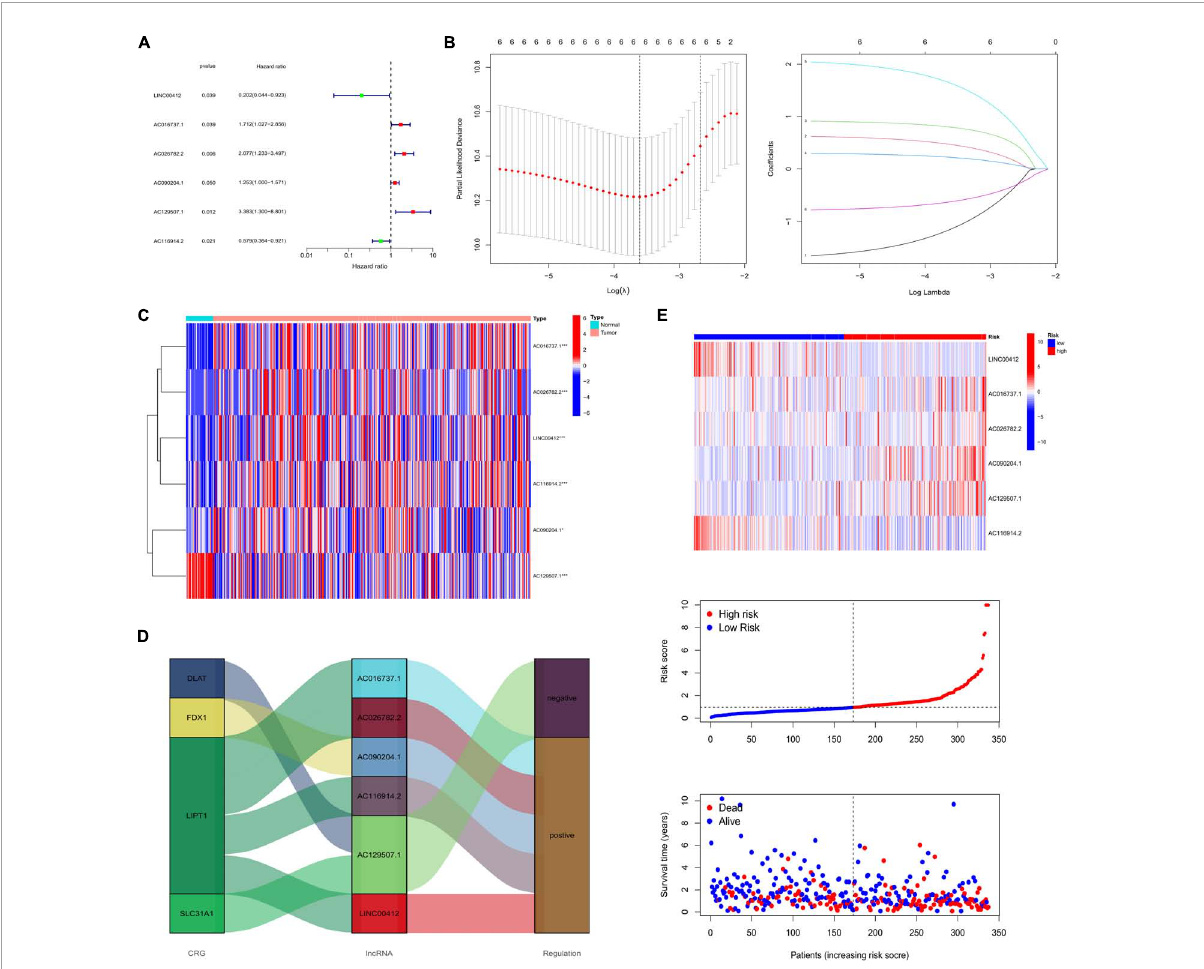
FIGURE2 (A) Univariate Cox regression analysis. (B) The LASSO algorithm further selected the most crucial genes and LASSO coefficient profiles. (C) Expression of risk lncRNAs between normal and tumor tissues. (D) Sankey diagram showing the relationship between CRGs and lncRNAs. (E) Heatmap showing the expression of risk lncRNAs between low- and high-risk groups, and the ranked dot plot showing the risk score distribution in all samples. (* P < 0.05; ** P < 0.01; *** P < 0.001; ns, not significant). LASSO, least absolute shrinkage and selection operator; CRGs, cuprotosis-related